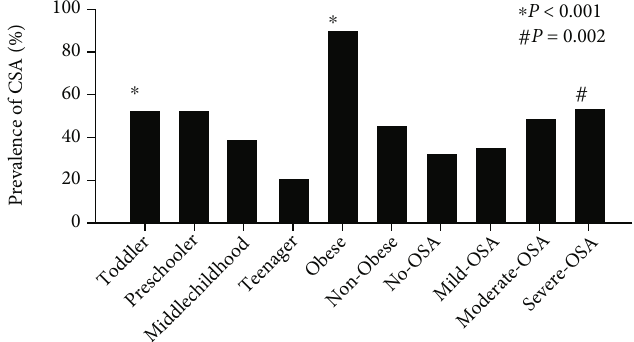
Figure 1: The prevalence of CSA amongst the studied age, weight, and OSA categories is shown. CSA was more prevalent in toddlers and preschoolers ( p < 0 : 001 ). Obese children had a higher prevalence of CSA compared to nonobese children ( p < 0 : 001 ). The prevalence of CSA in patients with moderate OSA and severe OSA was higher than that of patients with no OSA and mild OSA ( p = 0 : 002 ).